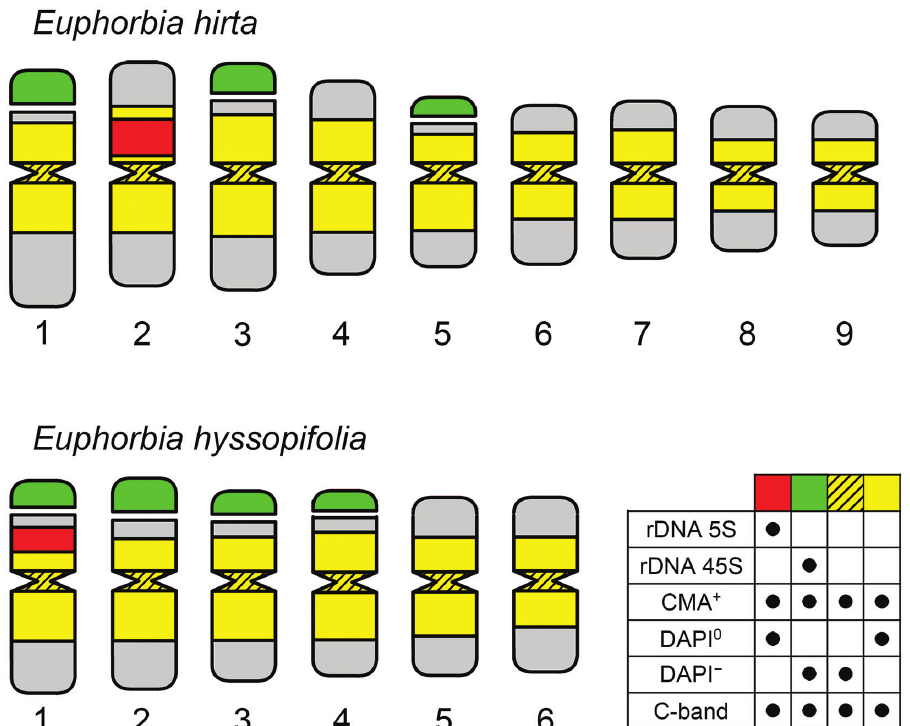
Figure 3. Representative idiograms of Euphorbia hirta and E. hyssopifolia chromosomes. The black dots in the chart in the inferior right corner associate the chromosome marks (rows) with their respective colors (columns) in the